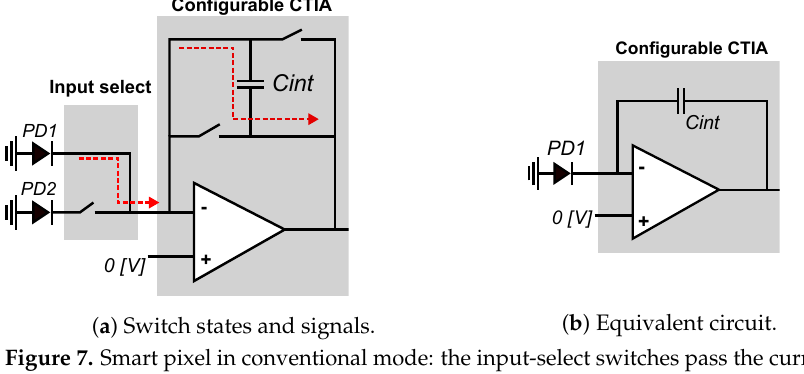
Figure 7. Smart pixel in conventional mode: the input-select switches pass the current from PD1, sw1 and sw4 are closed to integrate the current, and sw2 and sw3 stay open.